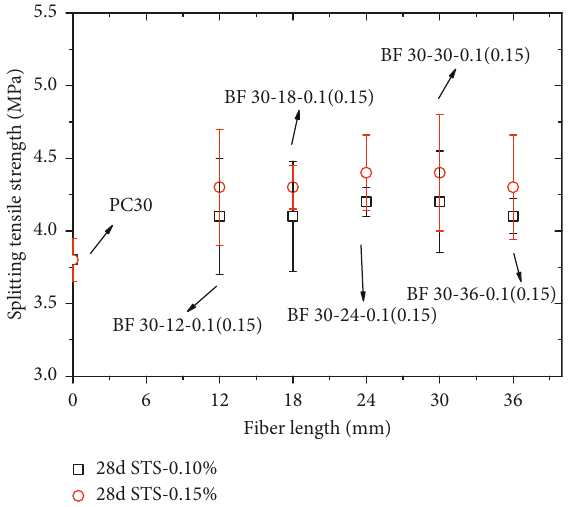
Figure 9: Effect of fiber length on splitting tensile strength (STS) for specimens PC30 and BF 30-(12 ∼